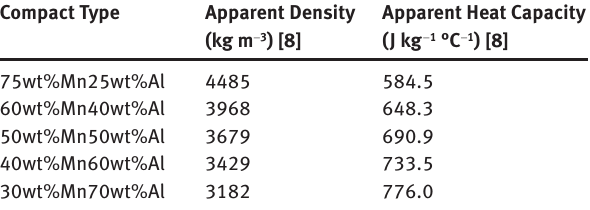
Table 1: Mn-Al compact apparent densities and apparent heat capacities